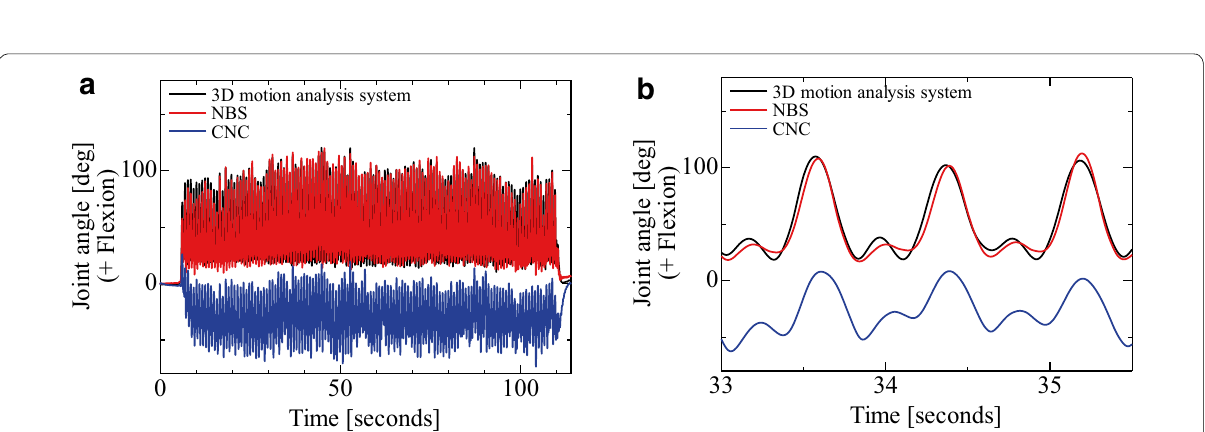
Fig. 5 Results obtained for knee joint angles (Subject A). a The results over the entire measurement time. b The results between 33 and 35.5 s.